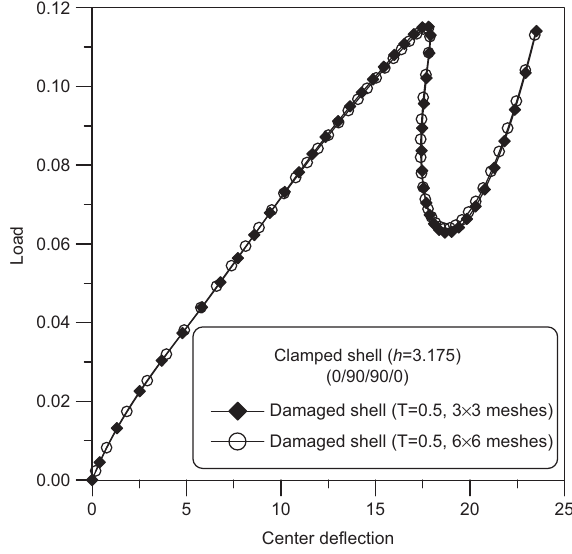
Figure 13 Load-displacement curves of clamped cylindrical shell. Figure 11 Geometry of clamped shell.